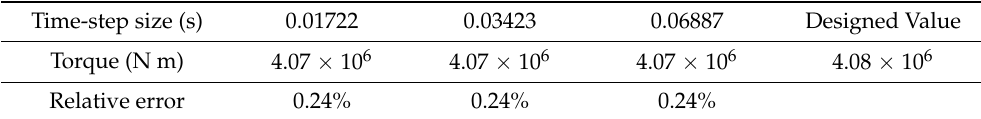
Table 1. Torque of different time-step sizes.